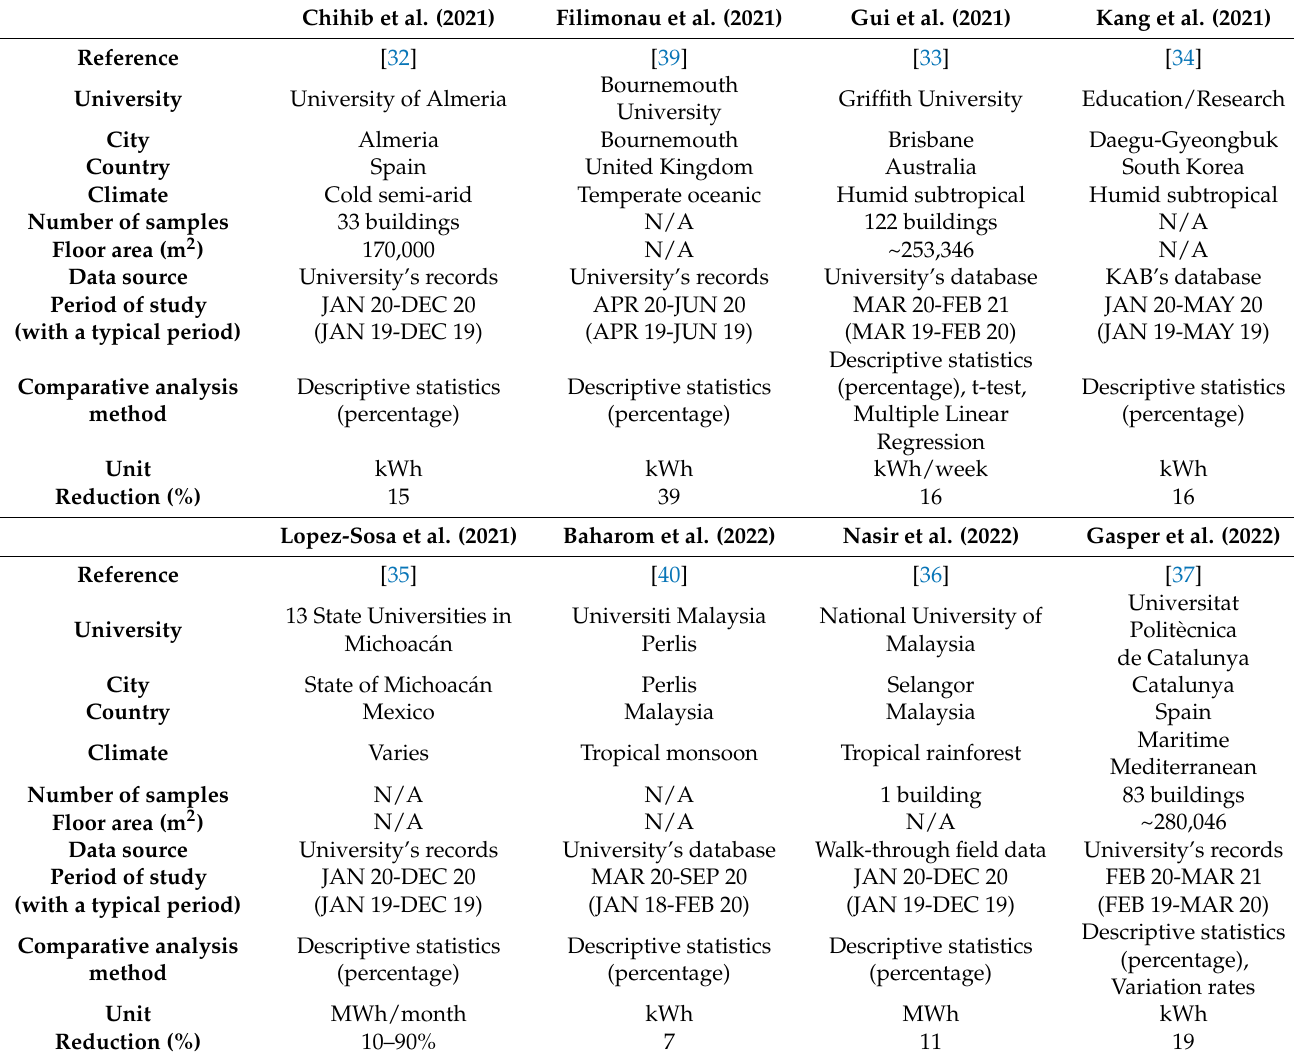
Table 1. Studies on electricity consumption during the COVID-19